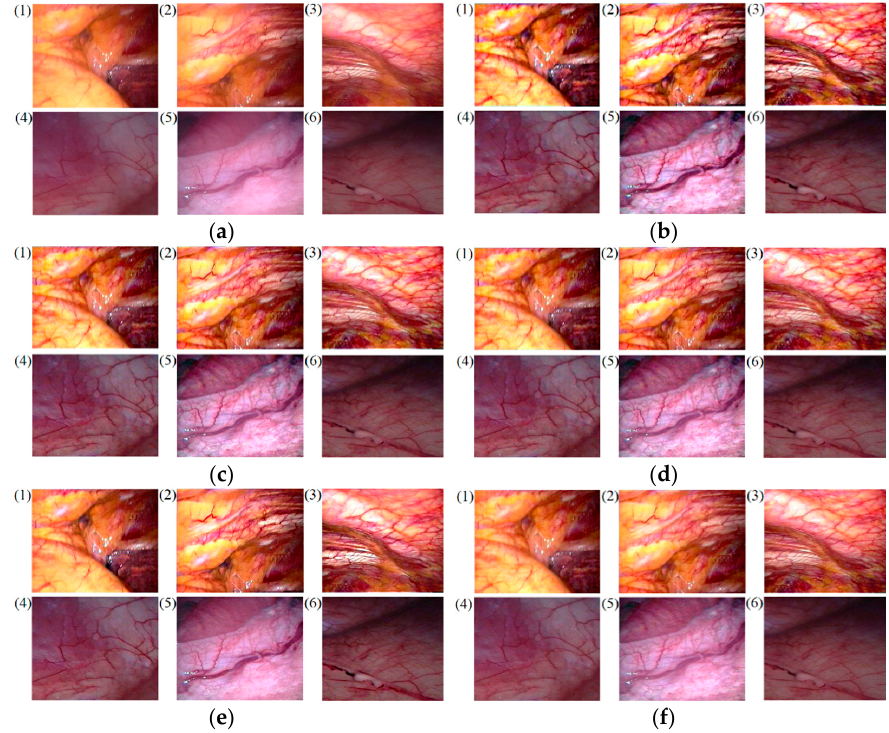
Figure 8. ( a ) Original image, ( b ) GIF renderings, ( c ) WGIF renderings, ( d ) GDGIF renderings, ( e ) EGIF renderings, and ( f ) the proposed algorithm renderings. Subfigures (1)–(6) are randomly selected Hamlin laparoscopic images .